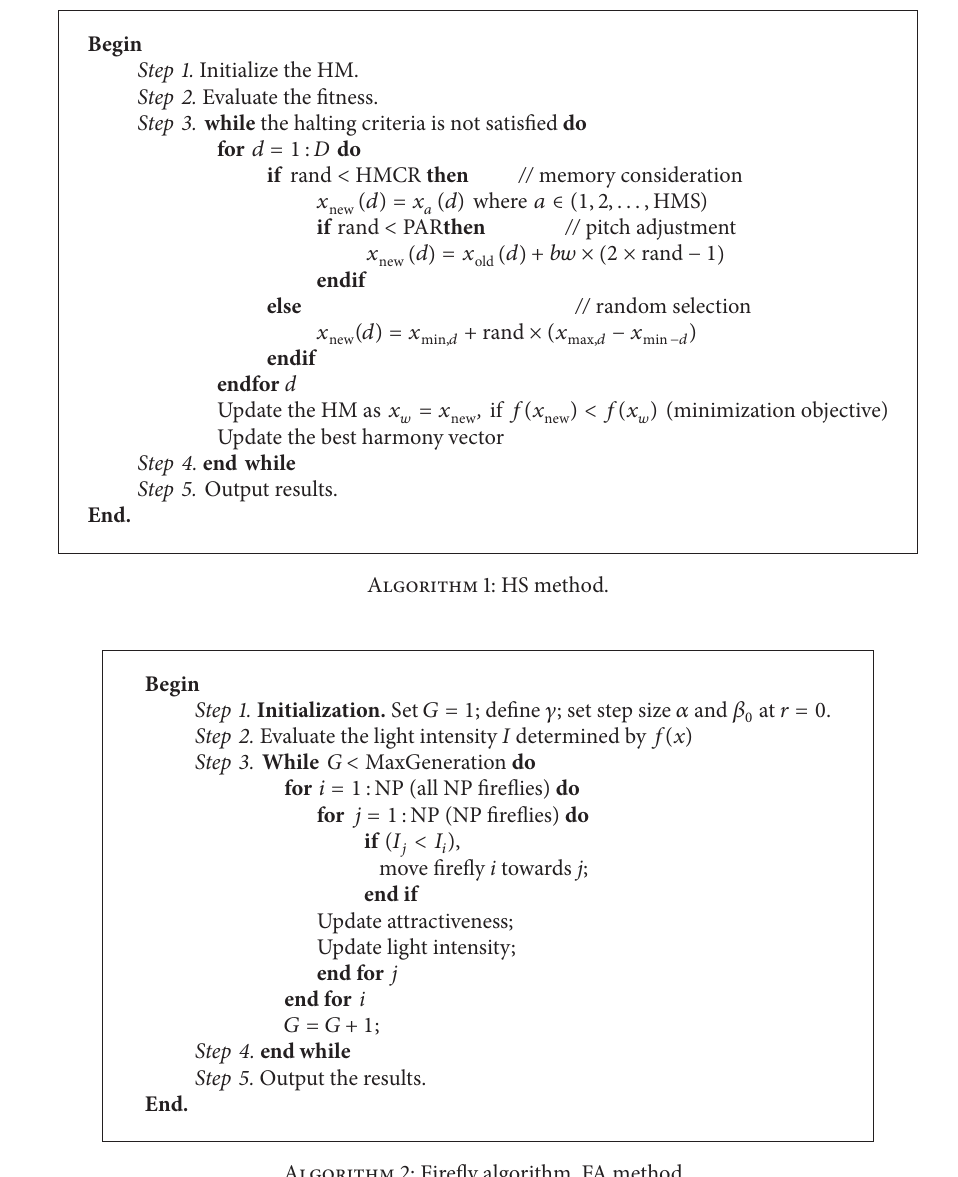
Algorithm 2: Firefly algorithm. FA